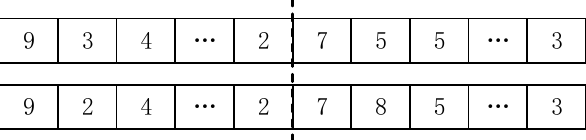
Figure 2. Coding method.